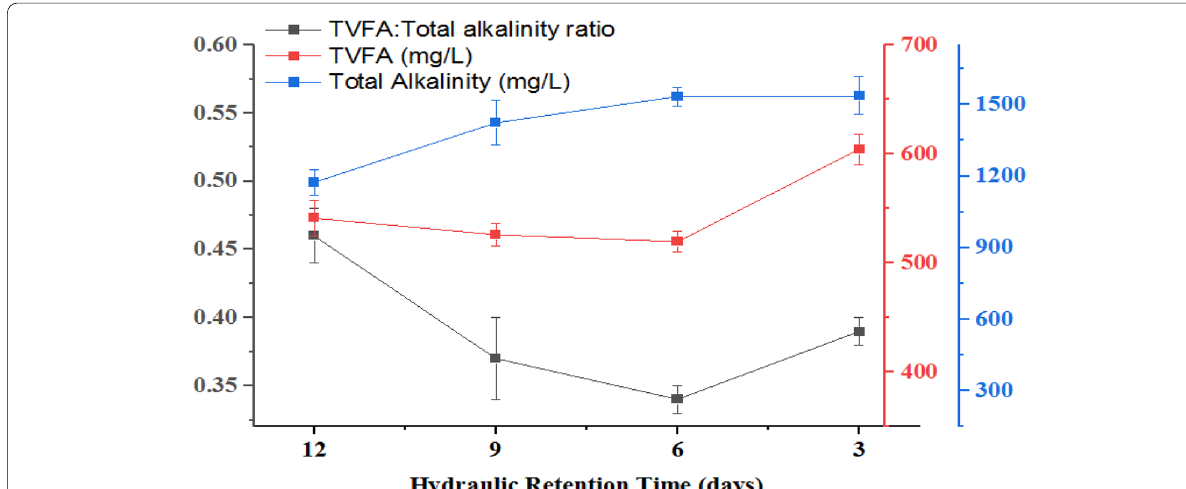
Fig. 3 Average TVFA, TotA and TVFA/TotA ratio of MR at different HRT and OLR